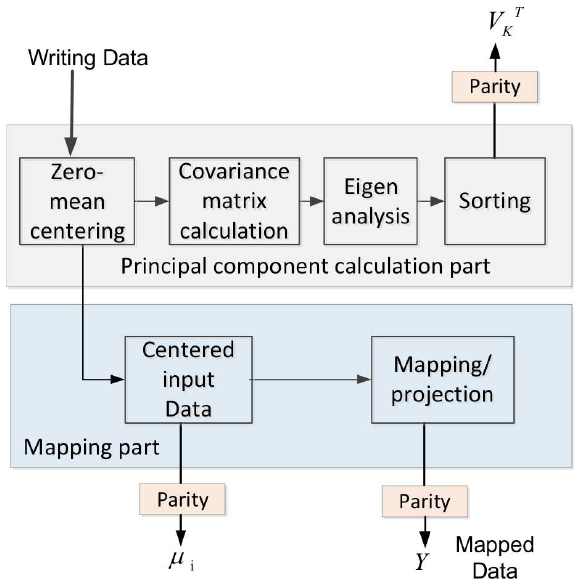
Figure 3. Extraction of principal components and reduction of dimensions to memory data with